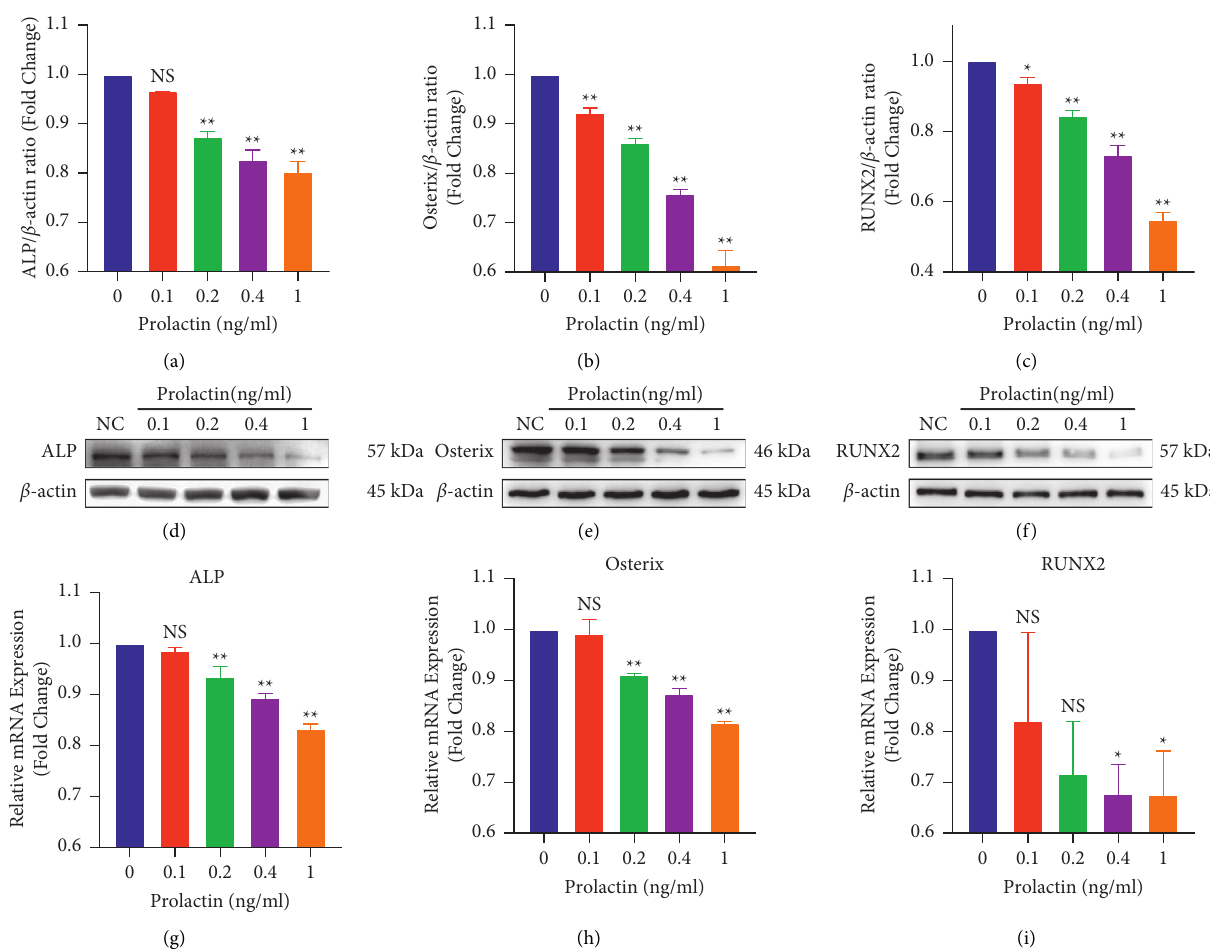
Figure 2: Prolactin inhibited the expression of osteoblast-related proteins and genes. (a–c) Quantification of the osteoblast-related proteins ALP, Osterix, and RUNX2. (d–f) Cell lysates were subjected to WB analysis with antibodies against these proteins. (g–i) Quantification of the mRNA expression of ALP , Osterix , and RUNX2 . n � 3; NS: not statistically significant, ∗ P < 0 . 05, ∗∗ P < 0 . 01, ∗ vs the NC